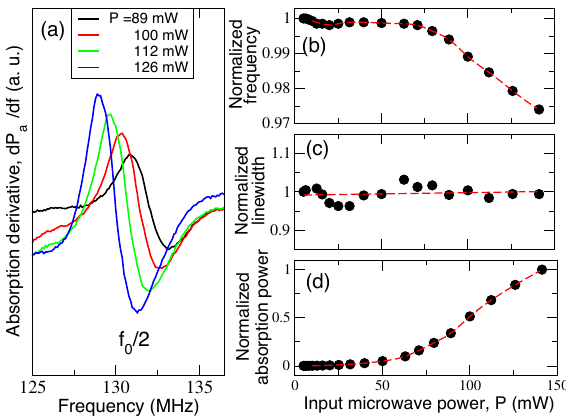
Figure 6. Experimental microwave power dependence for the 1 / 2 subharmonic Bloch DW resonance. (a) DW resonance spec- tra around f 0 / 2 for three values of the input microwave power. Input microwave power dependence for the resonance frequency (b), the resonance linewidth (c) and the power absorption at res- onance (d) of the subharmonic signal at f 0 / 2. The normalization rules are the same as in Fig. 4. The dashed lines are guides to the